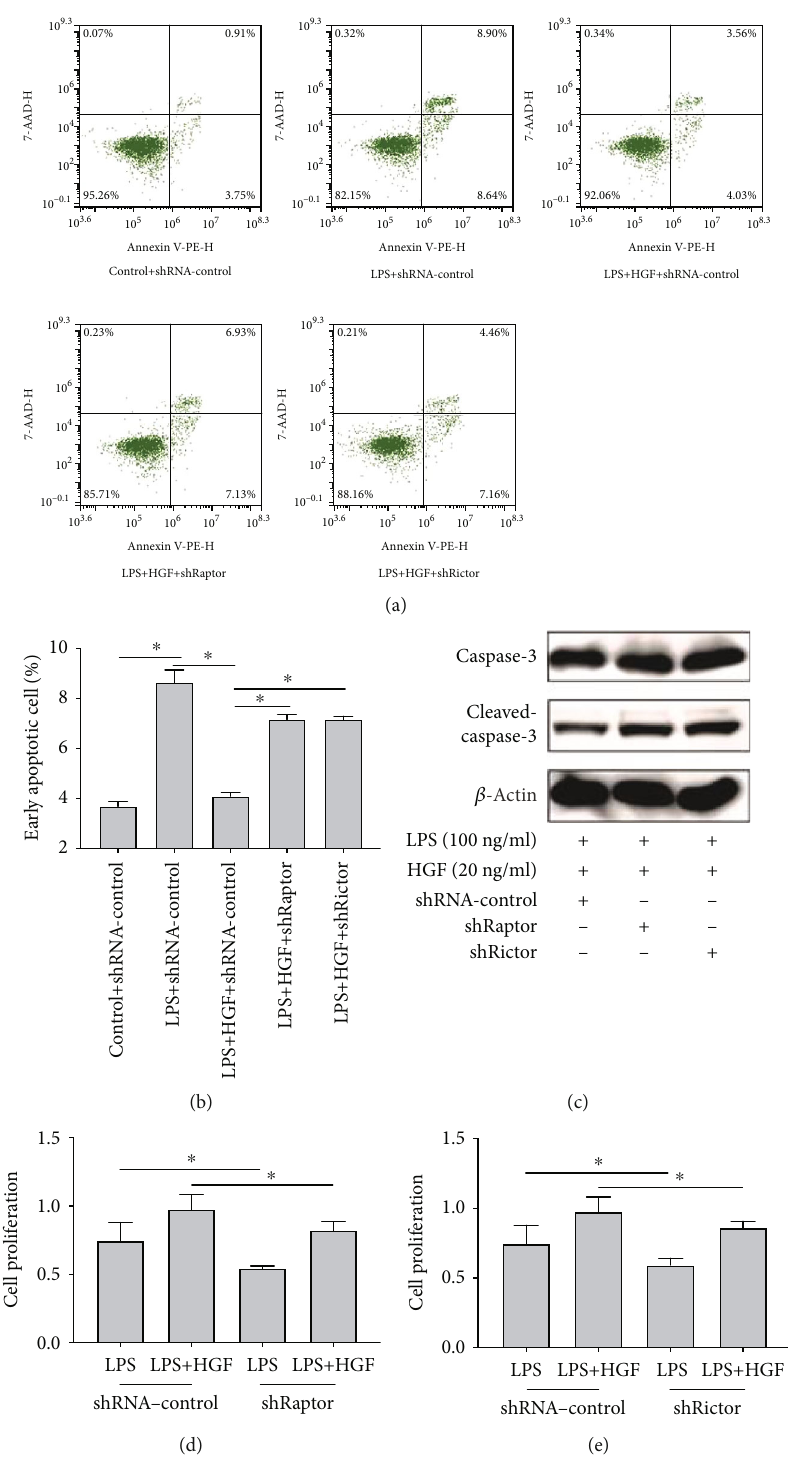
Figure 6: E ff ects of mTORC1 and mTORC2 to HGF on endothelial proliferation and apoptosis in LPS-induced PMVECs. Lentivirus vector- mediated mTORC1 and mTORC2 (raptor and rictor) knockdown in PMVECs (shRaptor and shRictor as knockdown, shRNA-control as negative control) was conducted. PMVECs were treated with HGF (20 ng/ml), with or without stimulation with LPS (100ng/ml) for 24h. (a) Flow-based scatter diagram of mTORC1/mTORC2 to cell apoptosis of HGF on LPS-induced PMVECs. (b) Flow-based early apoptosis ratio of mTORC1/mTORC2 to cell apoptosis of HGF on LPS-induced PMVECs. (c) The e ff ects of mTORC1 and mTORC2 to apoptosis-associated Caspase-3 protein expression of LPS-induced PMVECs with HGF treatments tested by western blot. (d) The e ff ects of mTORC1 to cell proliferation of HGF on LPS-induced PMVECs with CCK8. (e) The e ff ects of mTORC2 to cell proliferation of HGF on LPS-induced PMVECs with CCK8. Results are mean ± SD ( n = 3 ). ∗ p < 0 : 05